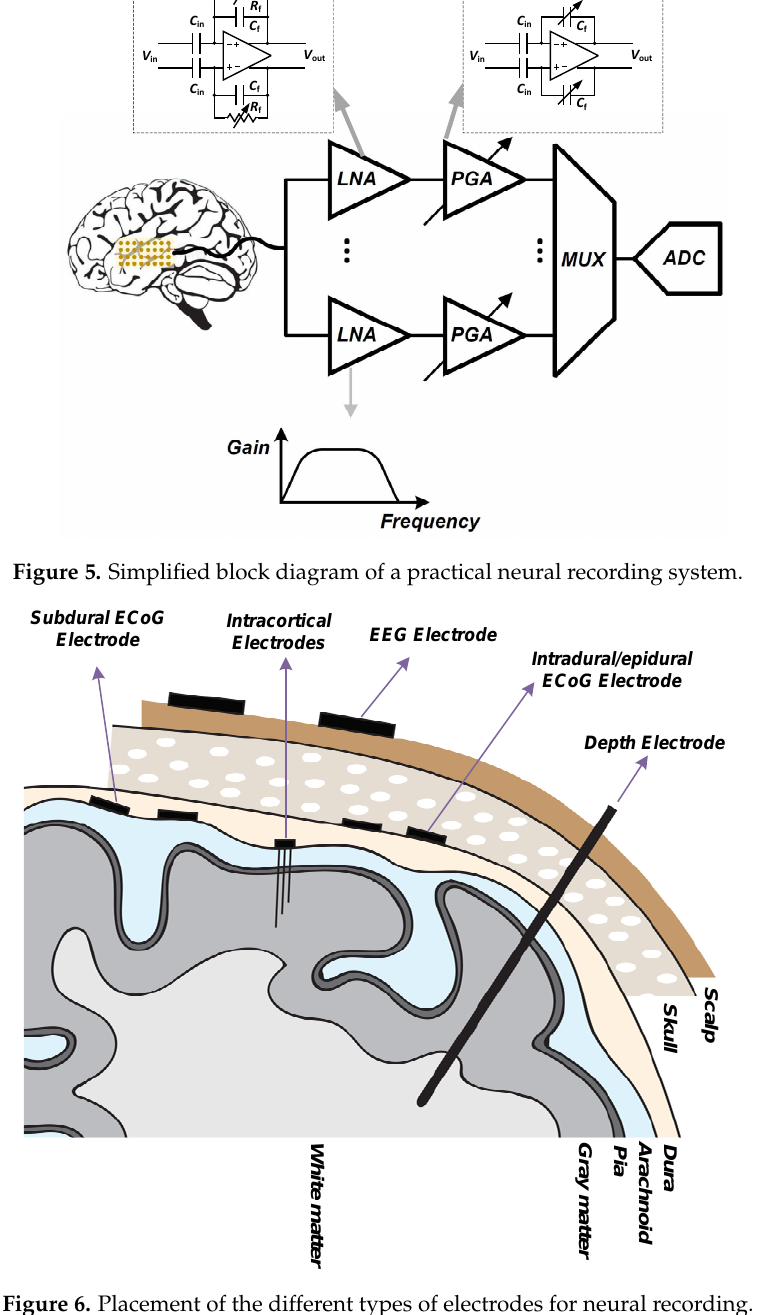
Figure 6. Placement of the different types of electrodes for neural